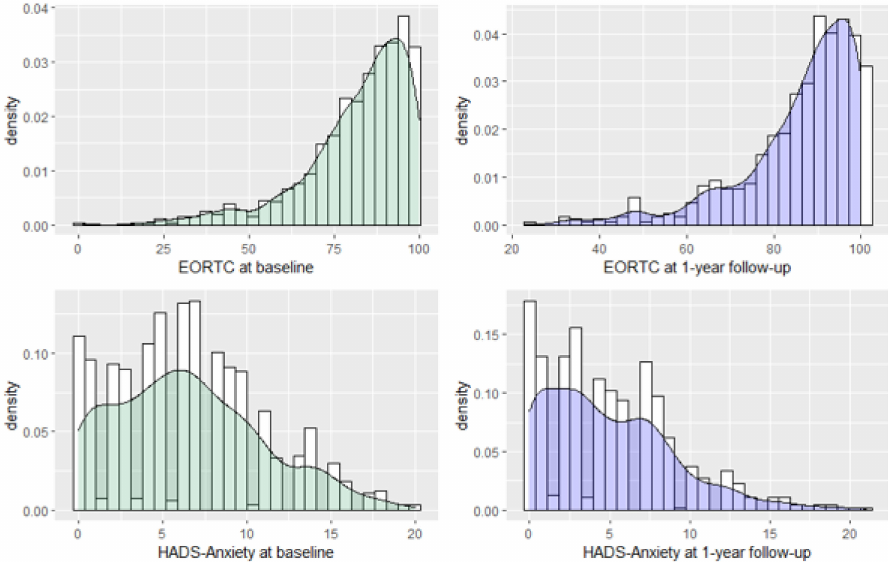
Figure 9. Distribution of the EORTC QLQ-C30 and HADS-A outcomes at the baseline and follow-up.